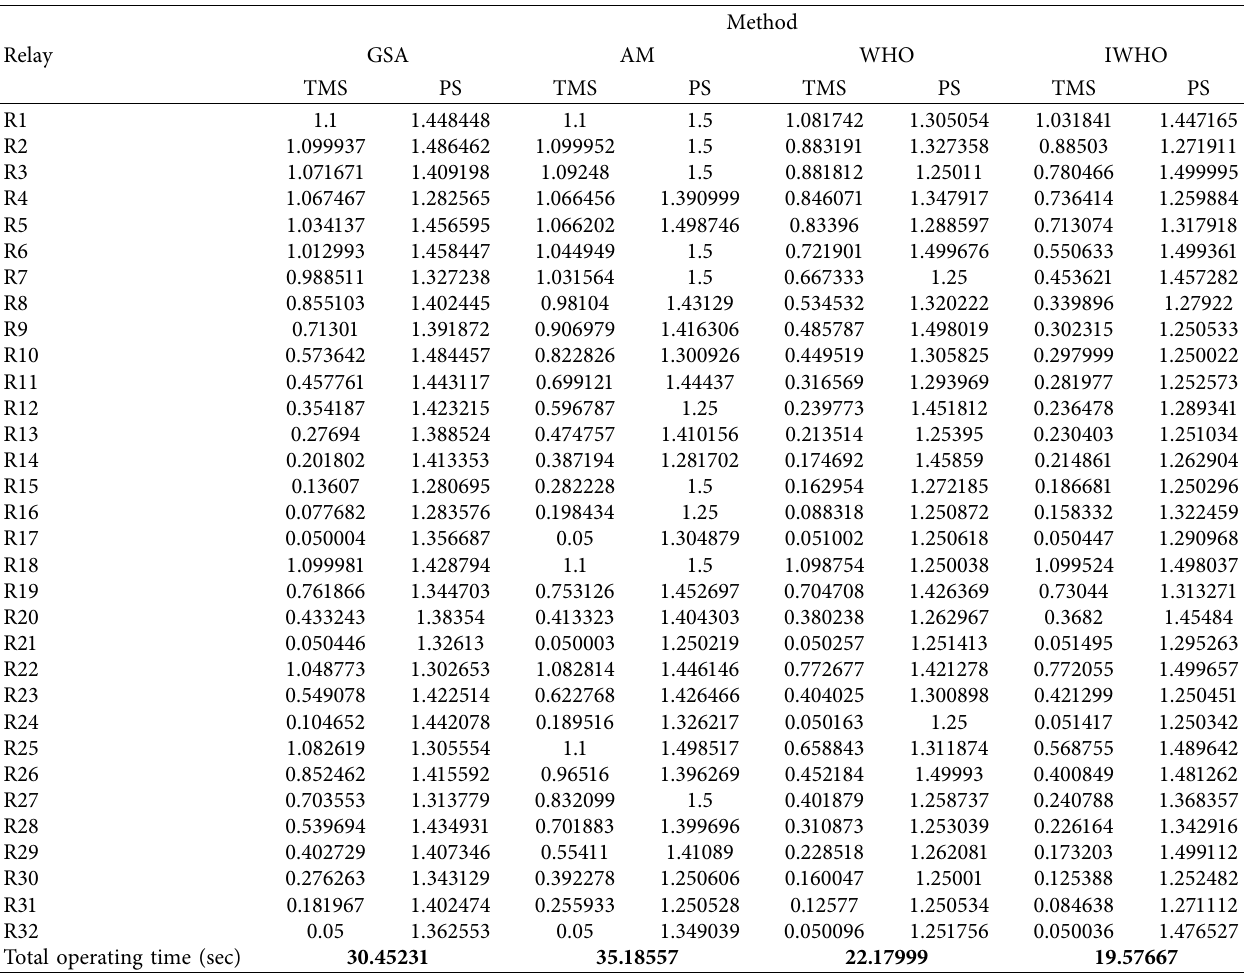
Table 2: Optimal setting variables’ results for the test system’s